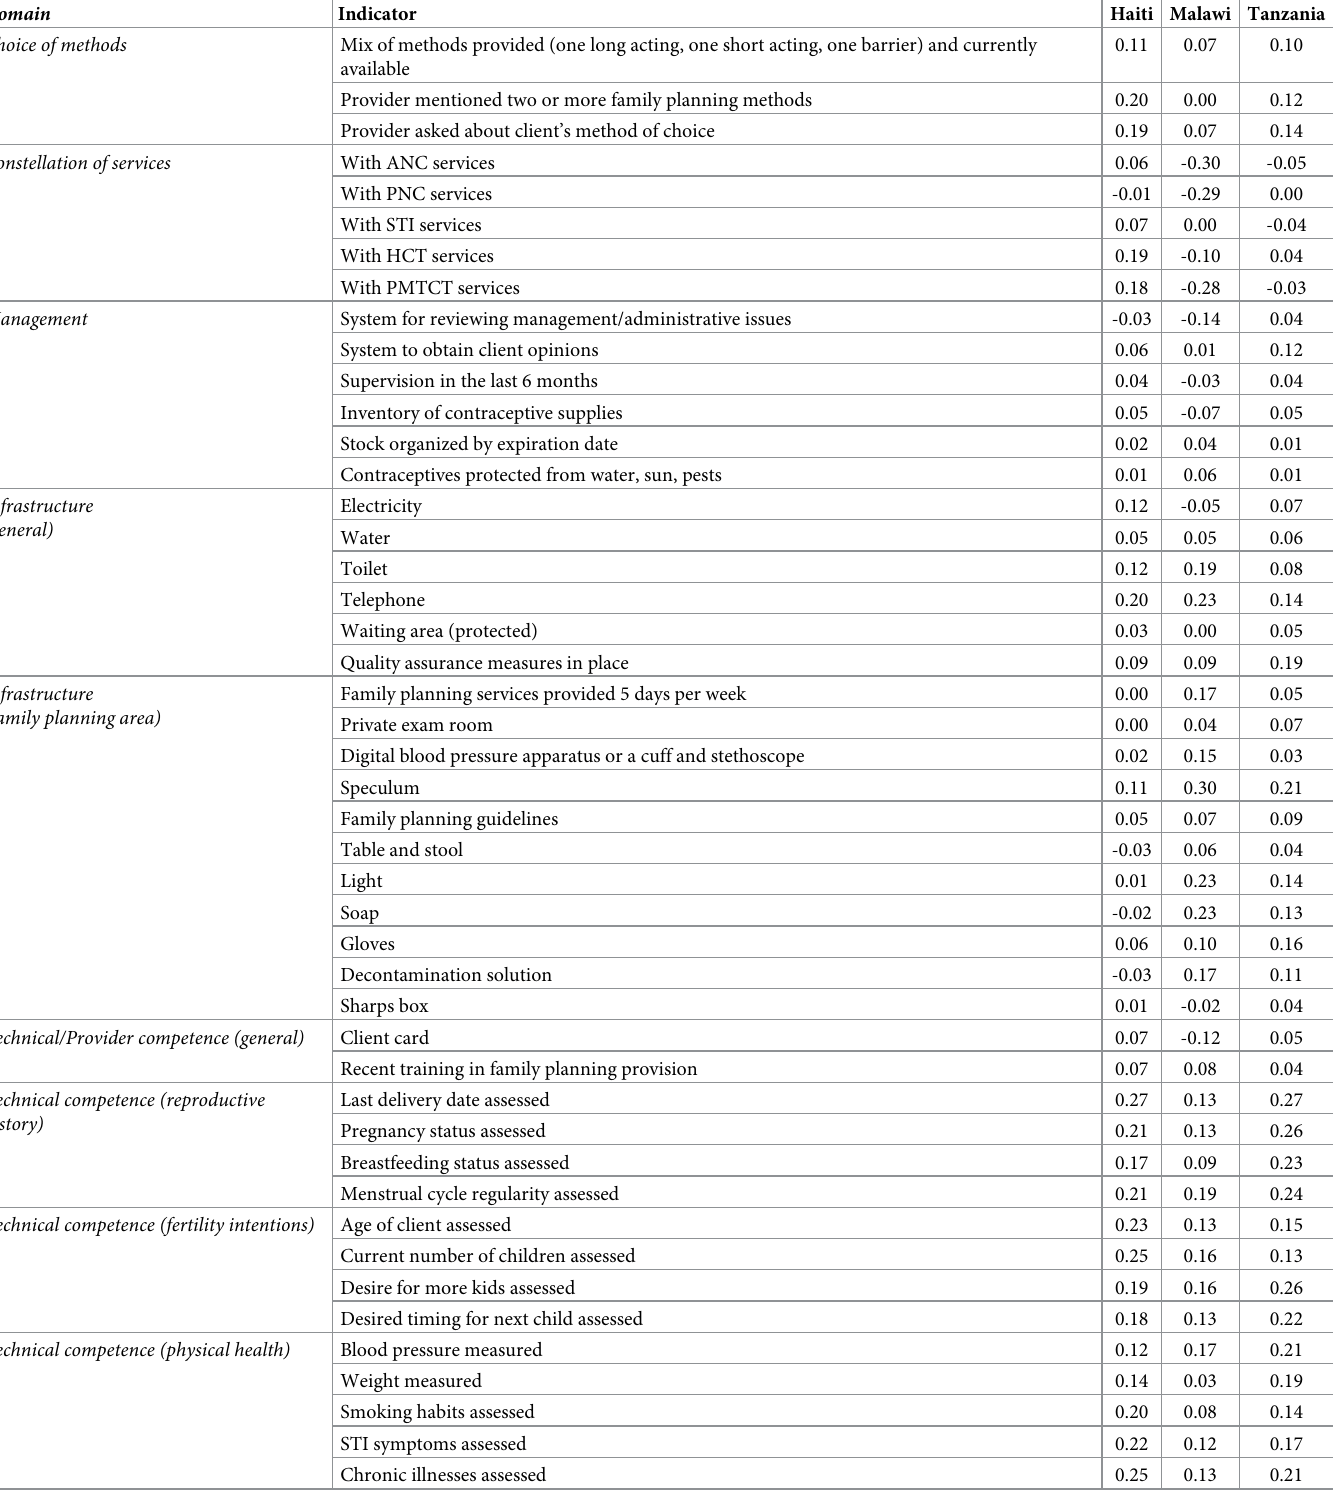
Table 4. Loadings of the first component of a PCA, eigenvalue, and % of variance explained.